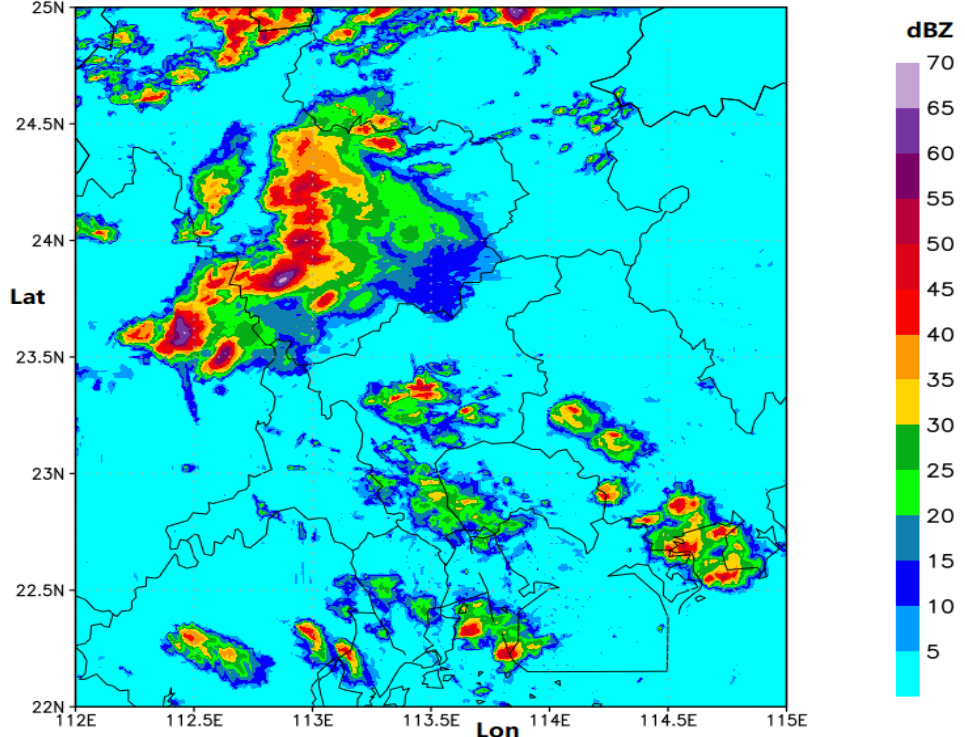
Figure 1. An example of radar echo image in the Southern China (around Guangzhou City) at 6 March 2021 00:00(UTC). 6 March 2021